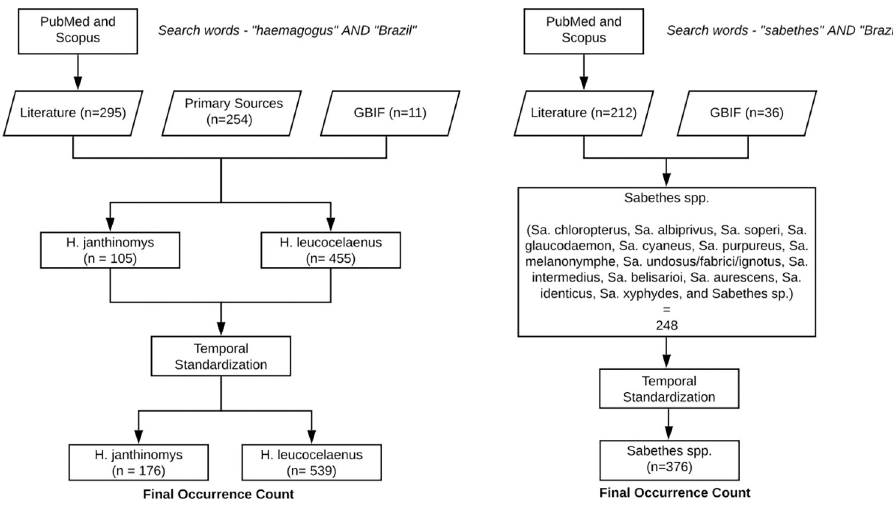
Fig 2. Number of occurrence records for Hg . janthinomys , Hg . leucocelaenus , and Sabethes spp . (1991–2019) prior and post standardization.